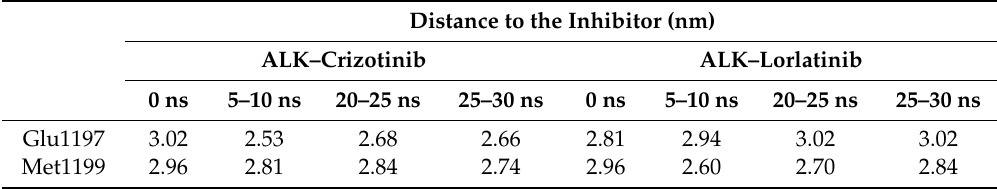
Table 1. Distance analysis of inhibitor to hydrogen bonds forming amino acids of ALK.